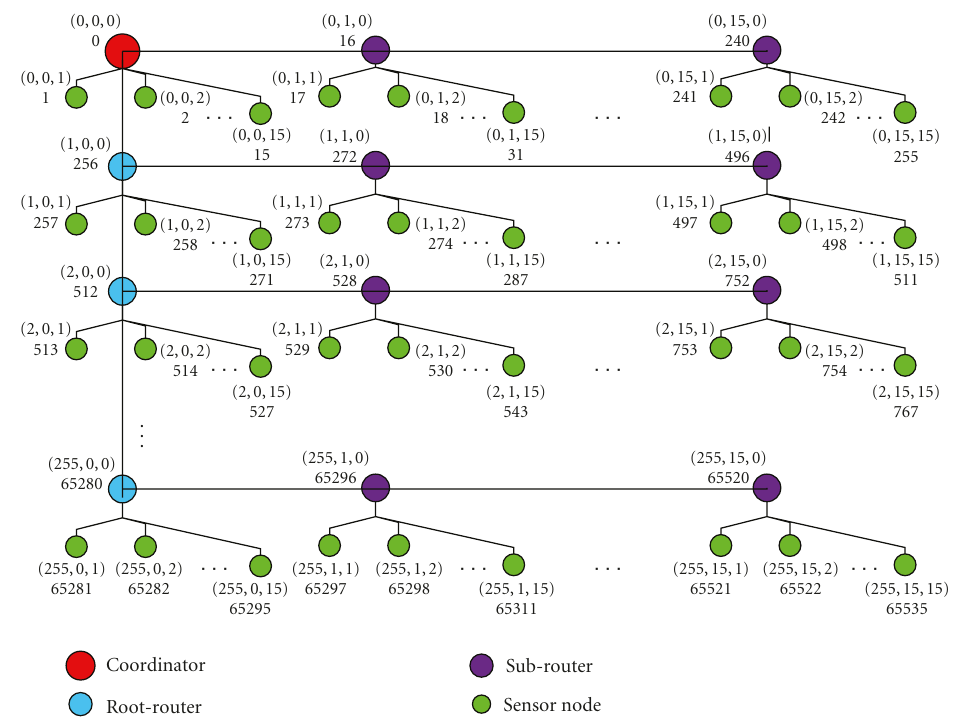
Figure 7: Illustration of address assignments for three-dimensional AACS